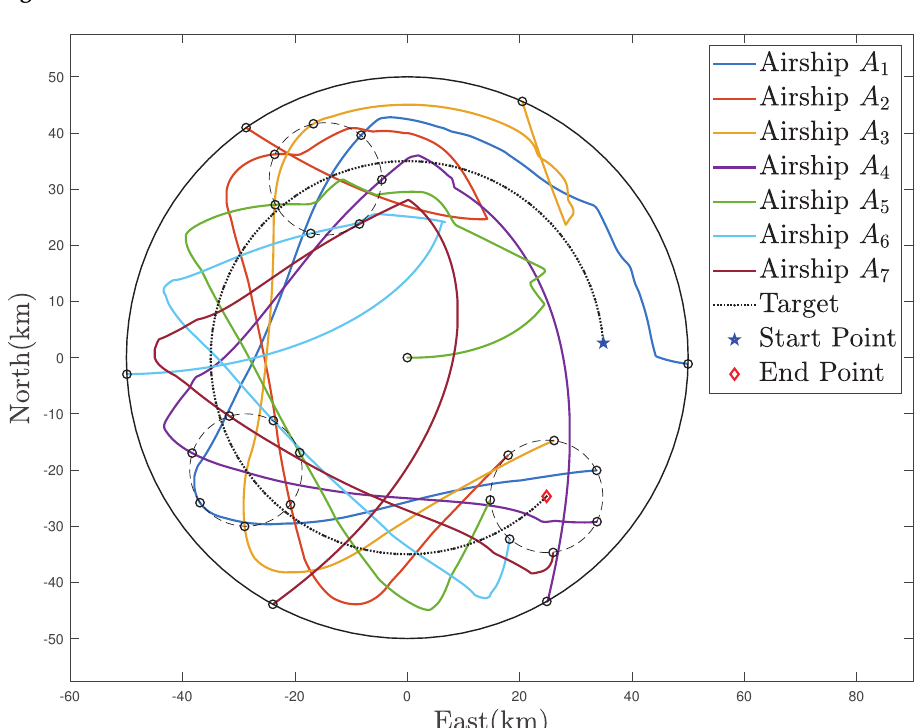
Figure 13. Trajectories of the MSAs system in the moving target coverage